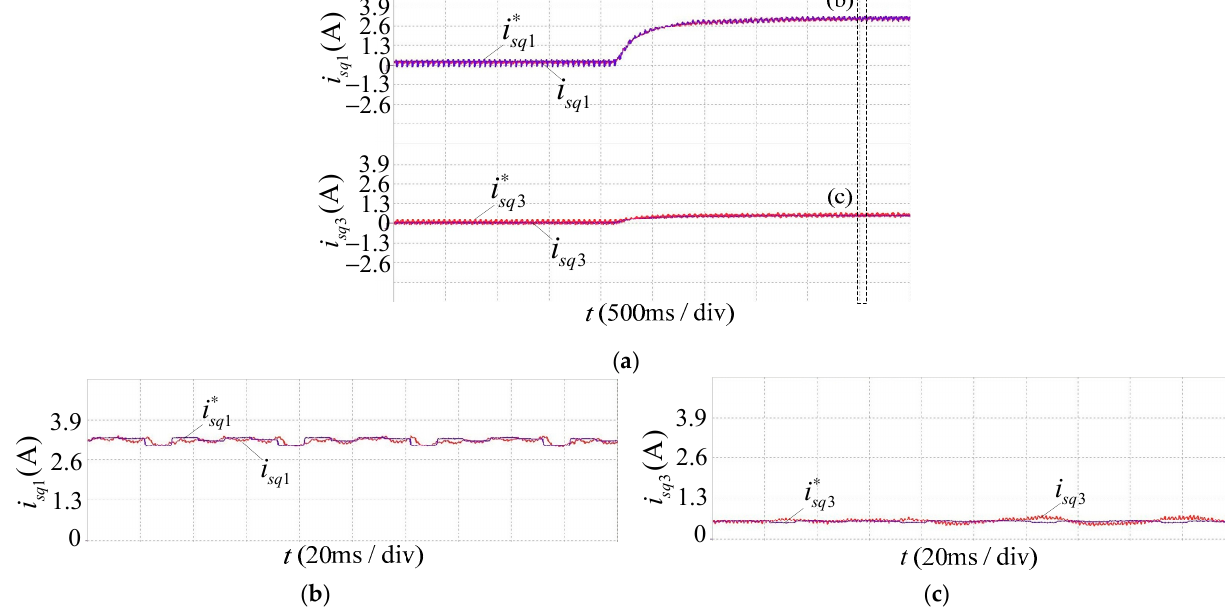
Figure 11. The inductance is 1.2 times the actual value for ( a ) the whole process; ( b ) the current i sq 1 ; and ( c ) the current i sq 3 .